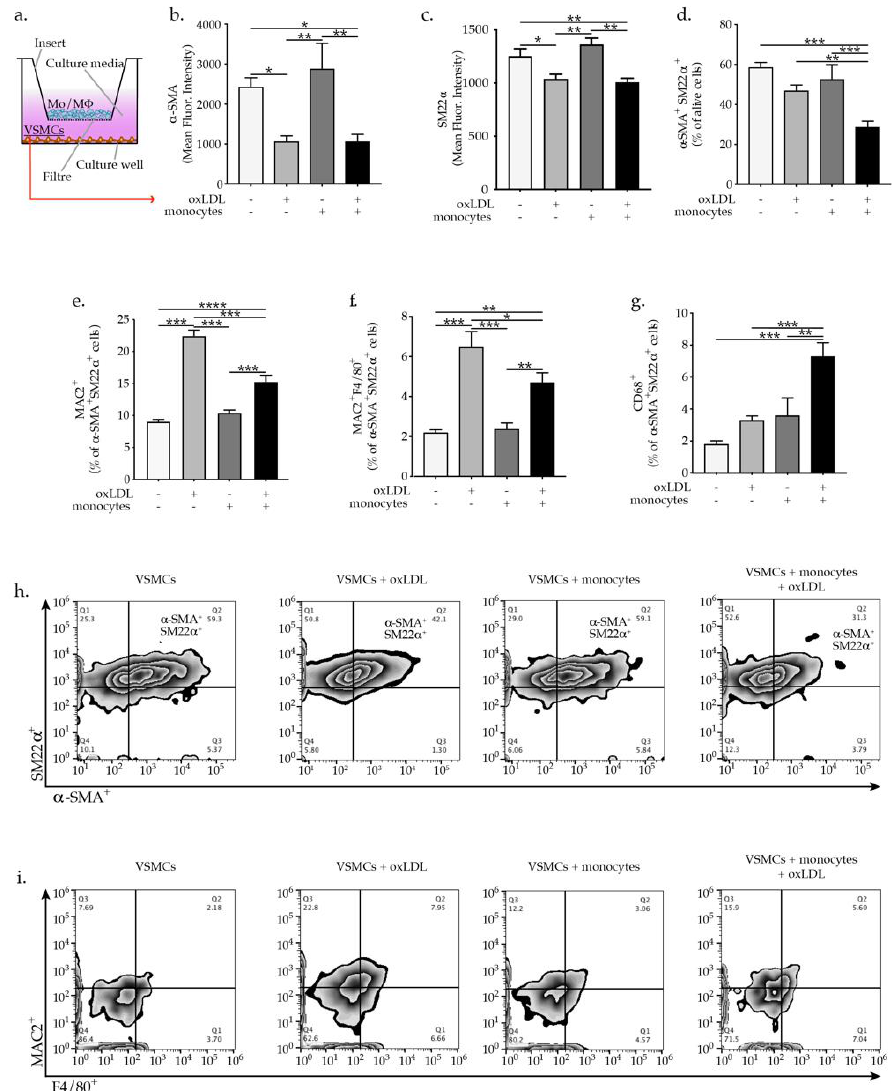
Figure 1. ( a ) Scheme of in vitro experimental setting and graph bars represent the mean ± SEM of flow cytometry analysis of VSMCs phenotypic switch ( b ) α -SMA + , ( c ) SM22 α + expressed as mean fluorescence intensity and ( d ) α -SMA + SM22 α + , ( e ) MAC2 + , ( f ) MAC2 + F4/80 + , and ( g ) CD68 + cells, expressed as percentage of indicated VSMC cells upon oxLDL treatment or co-culture with monocytes, with n = 6/group and * p < 0.05, ** p < 0.01, *** p < 0.001, and **** p < 0.0001, one-way ANOVA. Representative flow cytometry zebra plots of ( h ) α -SMA + SM22 α + and ( i ) MAC2 + F4/80 + expression quantification.